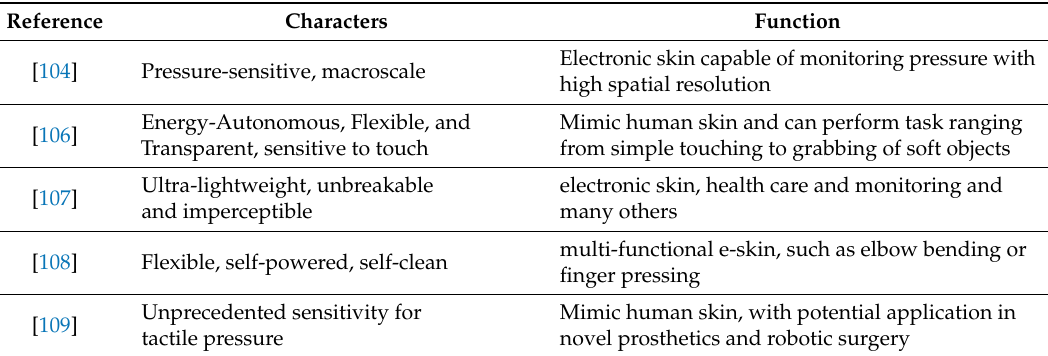
Table 4. Examples of existing tactile sensors for artificial